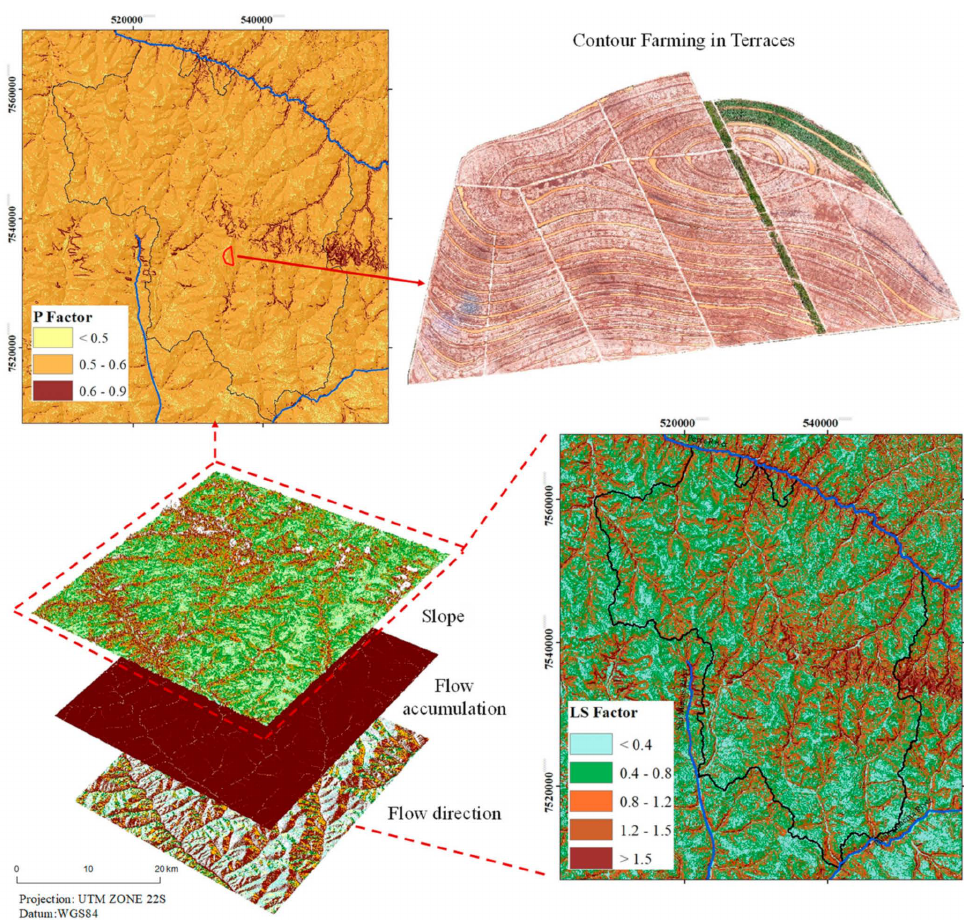
Figure 9. LS-Factor derived from the SRTM variables (slope, flow accumulation and flow direction) and P-Factor derived from slope and contour framing a support conservation